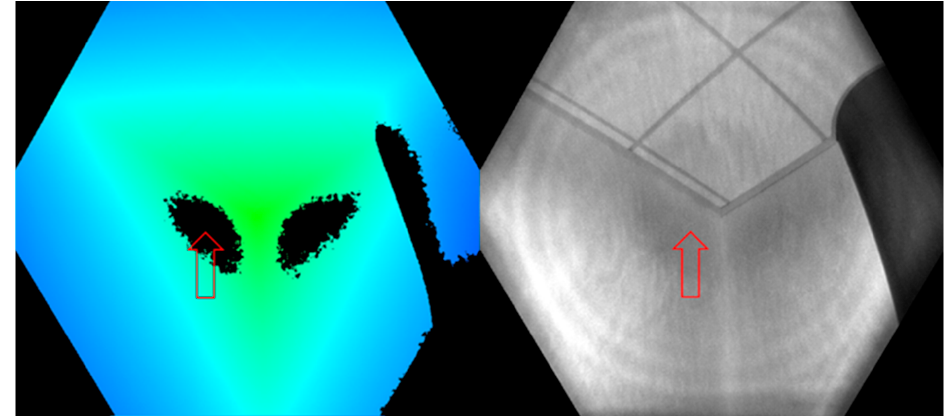
Figure 19. Multipath phenomenon observed on the intersection of two walls at the upper section corner of a room, as indicated by the red arrows. Pixels in black have zero depth values: depth image ( left ), passive infrared image ( right ). Microsoft.